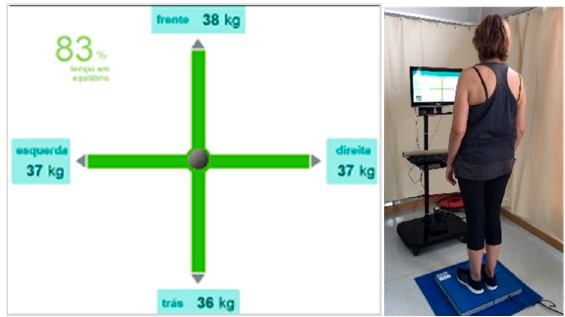
Figure 4. Monitor picture of physio sensing platform for feedback on balance.